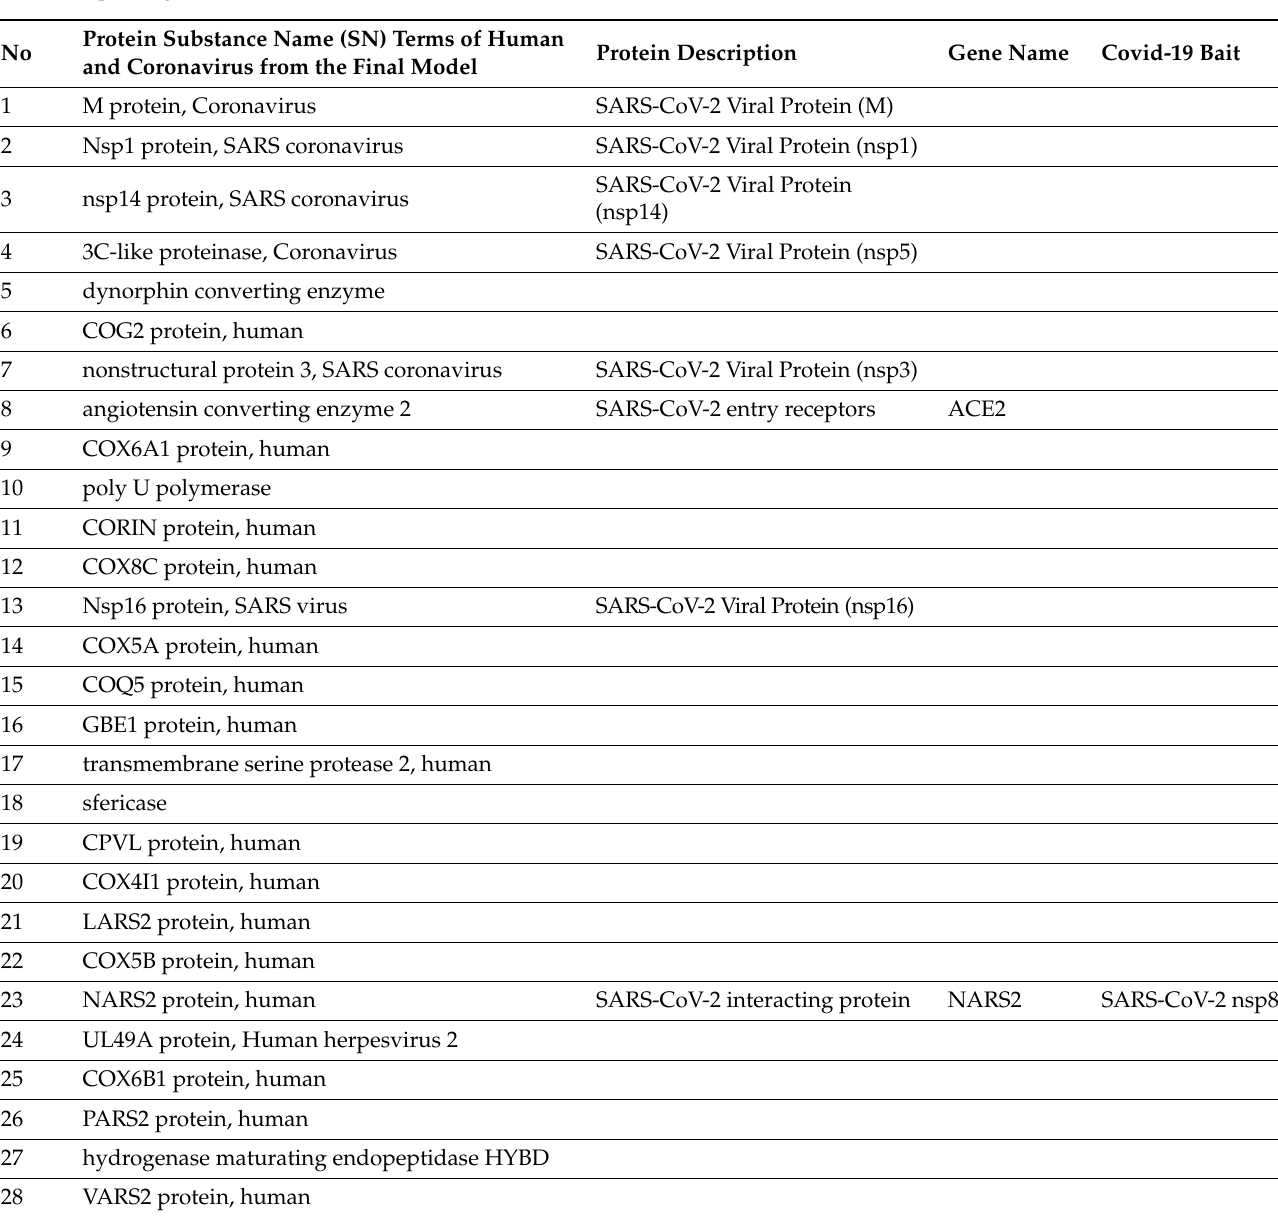
Table 4. List of coronavirus or human proteins extracted from the final model with high relevance to COVID-19 with protein description, gene name and covid-19 bait